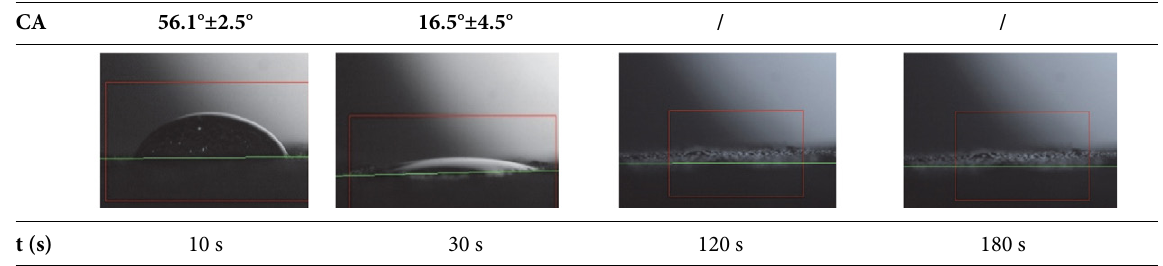
Table 2. Time-dependent contact angles of water droplets on new plasticized PVC membranes. CA